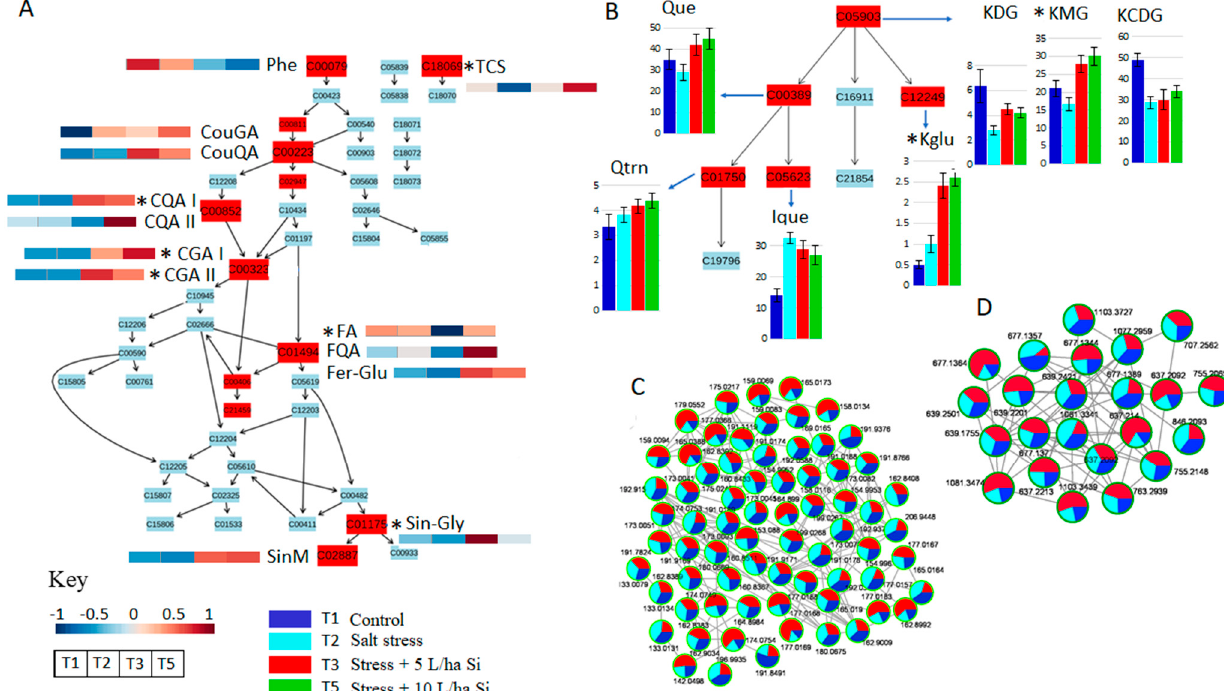
Figure 7. Secondary metabolic pathways and differential changes in corresponding phenolic compounds and their conjugates in non-stressed (T1: dark blue), salt-stressed (T2: light blue), and biostimulant treated salt-stressed (T3: red and T5: green) samples. The metabolite hits in the phenylpropanoid pathway ( A ) and the flavonoid biosynthesis pathway ( B ) are highlighted and matched to their corresponding graphical heatmaps representing relative amounts of each metabolite in different treatments. The asterisk (*) on metabolite titles indicate statistically significant differences ( t -test: p -value < 0.05) in metabolite levels. ( C ) and ( D ), illustrate treatment-based ion abundance in molecular network clusters of cinnamic acids, flavonoids, and their derivatives, respectively.